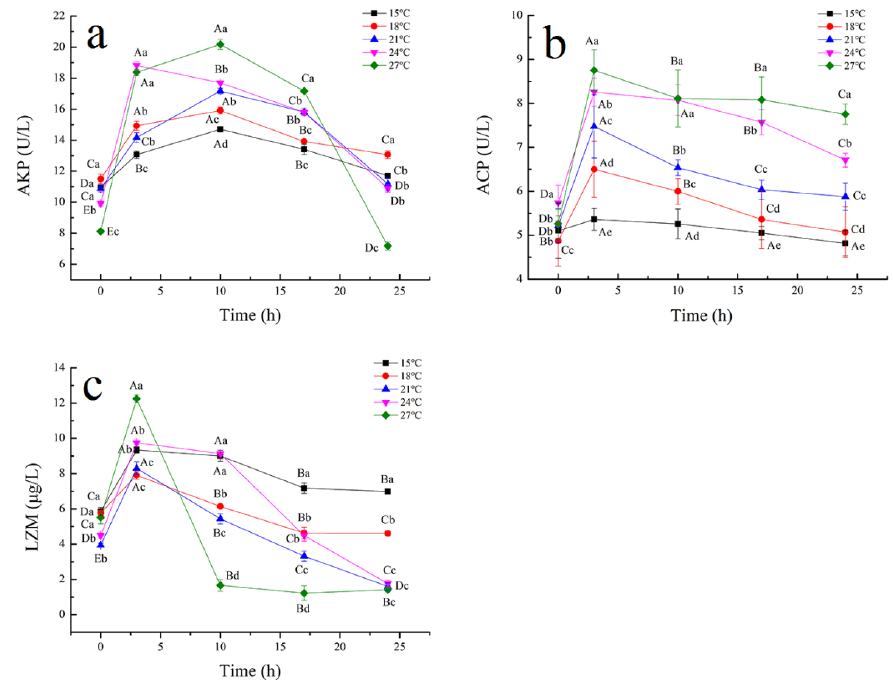
Figure 3. E ff ect of temperature on alkaline phosphatase (AKP) ( a ), acid phosphatase (ACP) ( b ), Figure 3. Effect of temperature on alkaline phosphatase (AKP) ( a ), acid phosphatase (ACP) and lysozyme (LZM) ( c ) of tiger grouper during simulated transport. Among di ff erent temperature ( b ), and lysozyme (LZM) ( c ) of tiger grouper during simulated transport. Among different temperature transport groups, different small and capital letters indicate the results of transport groups, di ff erent small and capital letters indicate the results of Duncan’s test at di ff erent Duncan’s test at different transport time. The same letters mean no significant difference ( p > transport time. The same letters mean no significant di ff erence ( p > 0.05), while di ff erent letters mean 0.05), while different letters mean significant difference ( p < 0.05). Different letters without * = significant di ff erence ( p < 0.05). Di ff erent letters without * = p -value < 0.05, di ff erent letters with p- value < 0.05, different letters with ** = p- value < 0.01. ** = p -value <